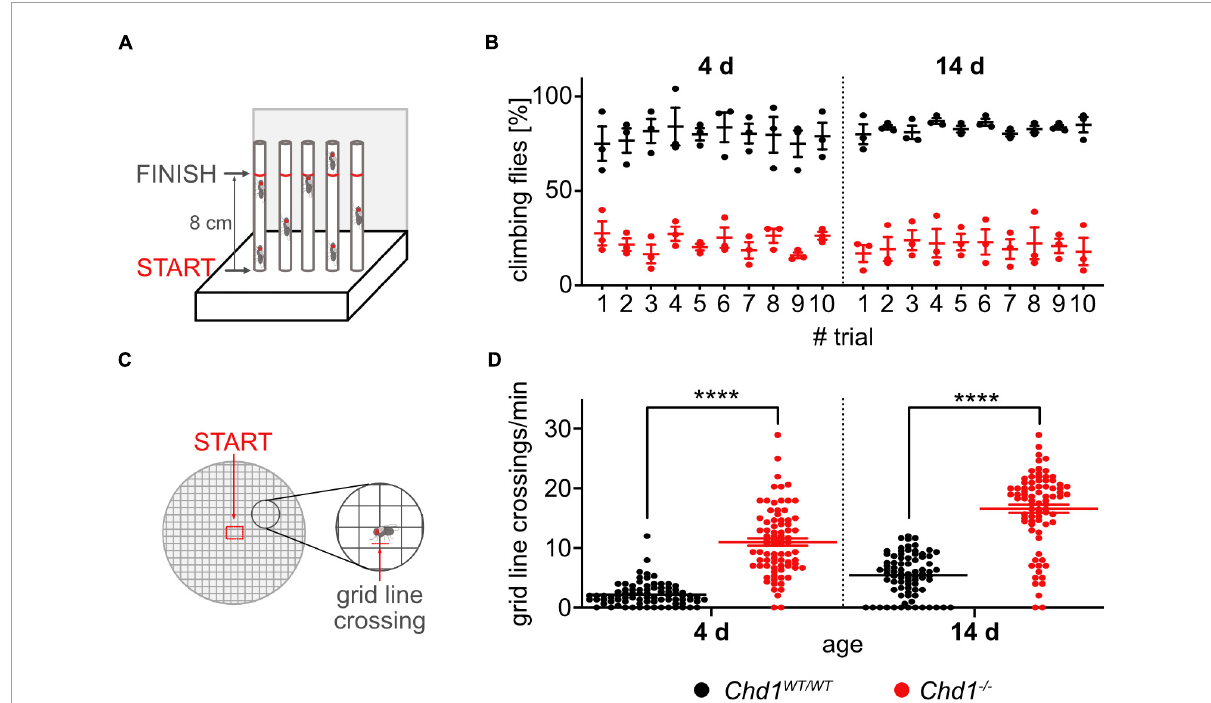
FIGURE3 Compromised climbing and exploratory walking behavior of Chd1 -deficient flies. (A) Experimental set-up of the negative geotaxis assay. (B) Percentage of 4 and 14 days old flies climbing to 8 cm height within 60 s in 10 trials. Mean ± SEM of 5 cohorts of 10–12 flies per genotype from 3 independent experiments is shown. 3-way ANOVA results for genotype main effect: F (1,8) = 197.2, p < 0.0001; age main effect: F (1,8) = 0.05742, p = 0.8167. (C) Experimental set-up for exploratory walking behavior. (D) Gridline crossings of individual 4 and 14 days old flies during 1 min were scored. Three independent experiments of n > 40 per genotype/experiment were performed. Statistical significance was determined by unpaired Student’s t -test. **** p <